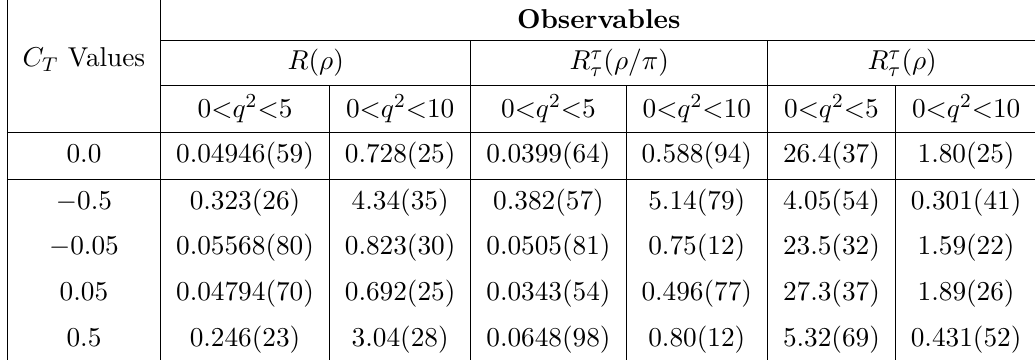
Table 14. NP predictions at differnt values for the corresponding Wilson coefficients (taken one at a time) corresponding to the B → ρ observables.